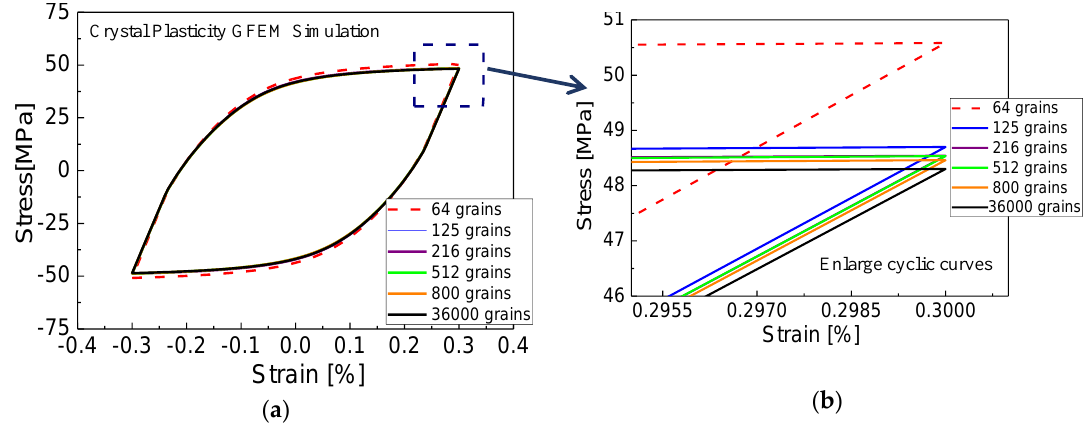
Figure 9. Comparison of steady hysteresis loops under cyclic tension-compression loading simulated by thin-walled tube specimen with different number of grains: (a) steady hysteresis loops with crystal plasticity GFEM simulation; (b) the enlarge graph of steady hysteresis loops.